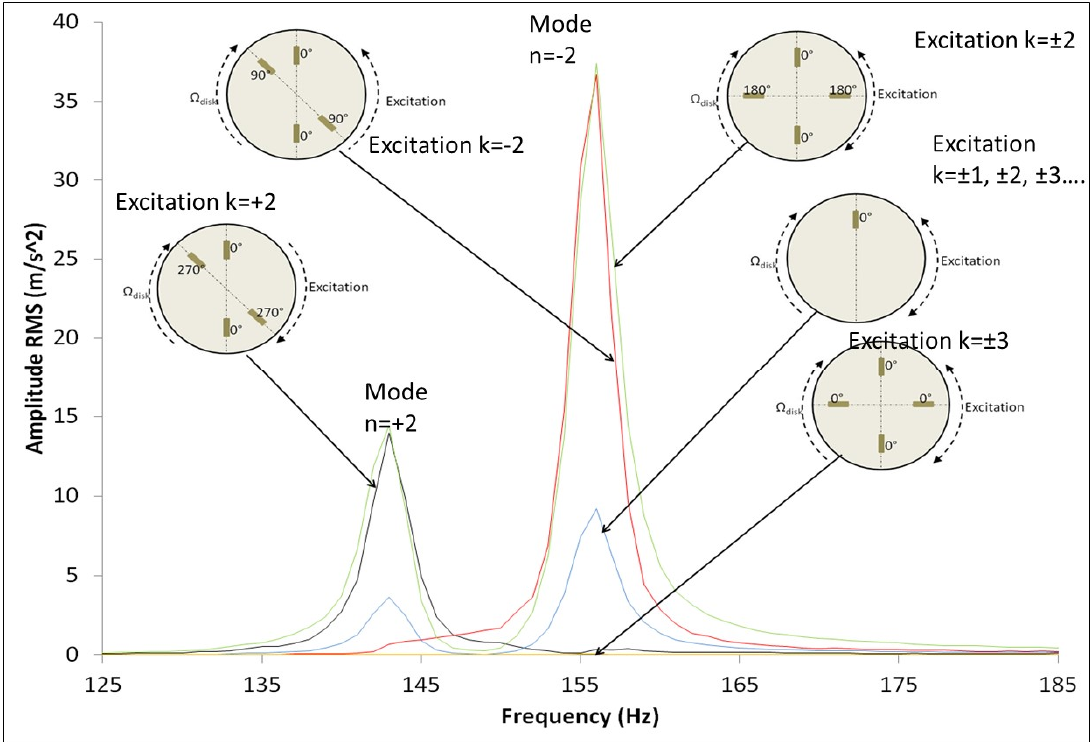
Figure 2. The excitation of the rotating mode shapes of a rotating submerged disk by means of PZT patches [26].